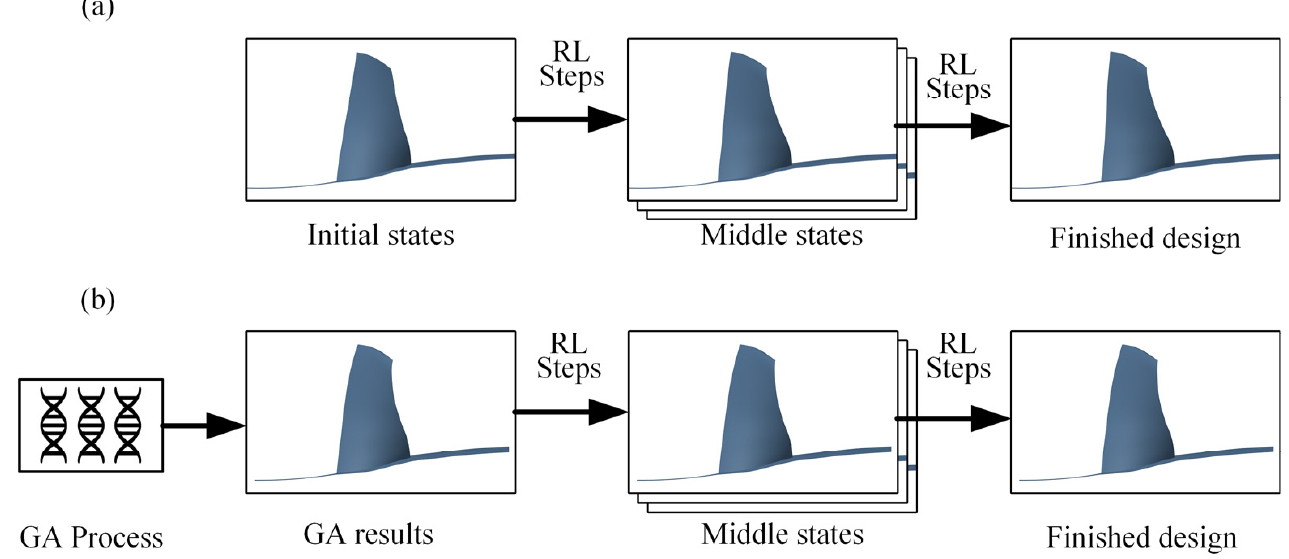
Figure 9. RL design process and its combination with GA: ( a ) RL process; ( b ) combination of RL and GA.